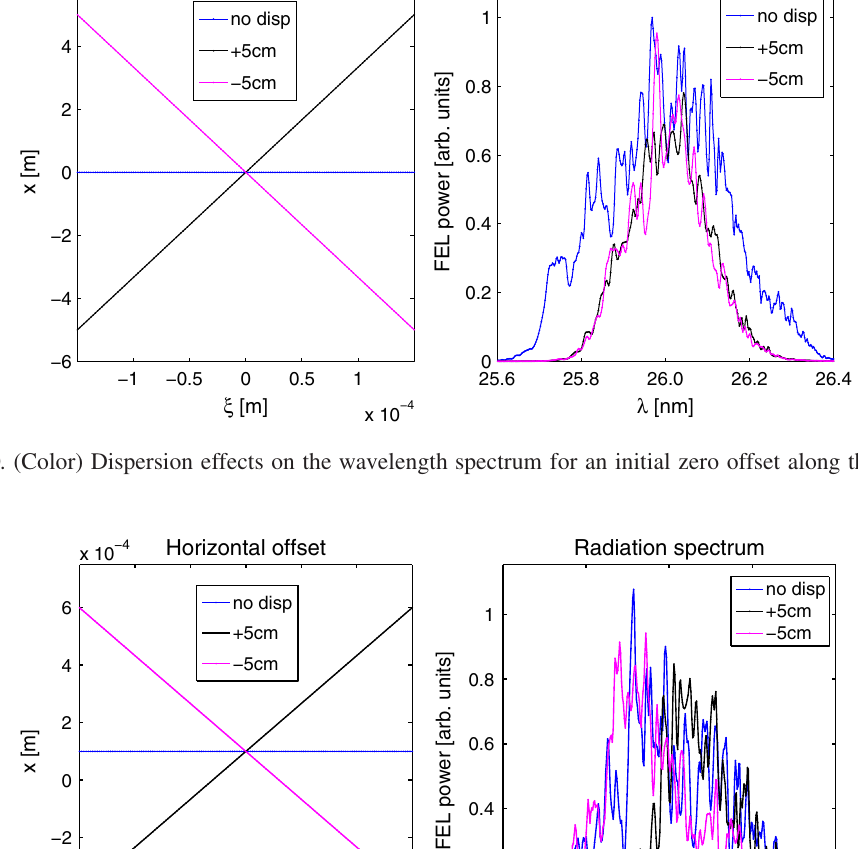
DISPERSION EFFECTS ON . .